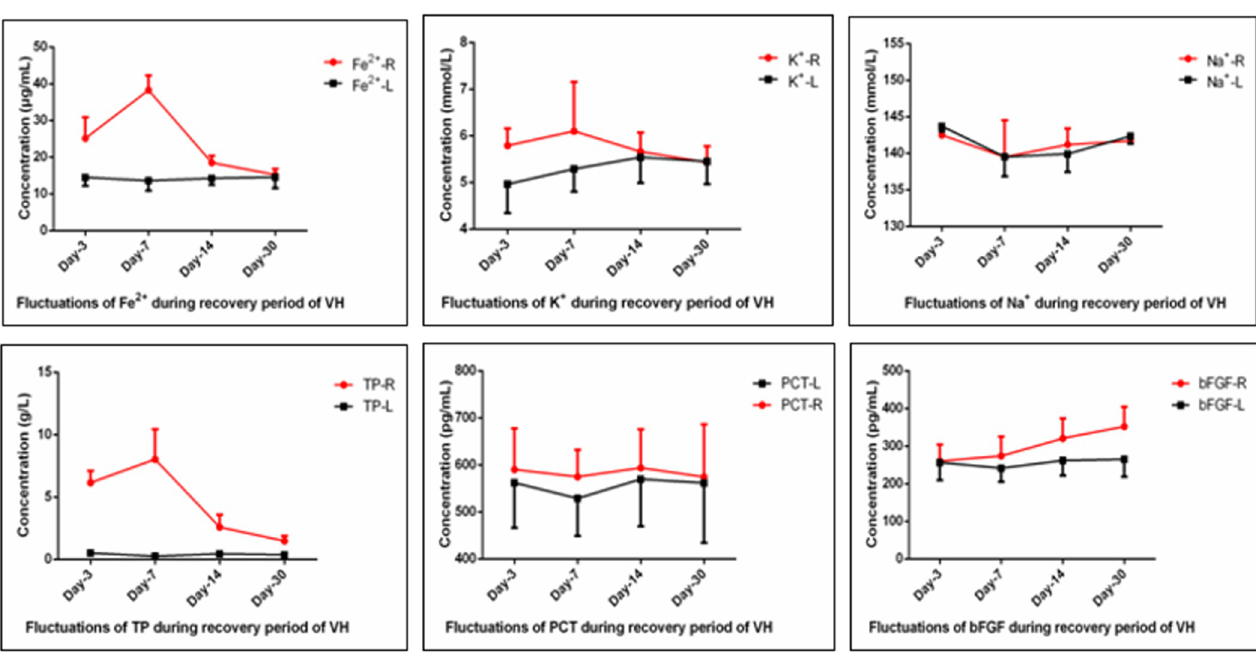
Fig 2. Line chart of changes in biochemical indicators after